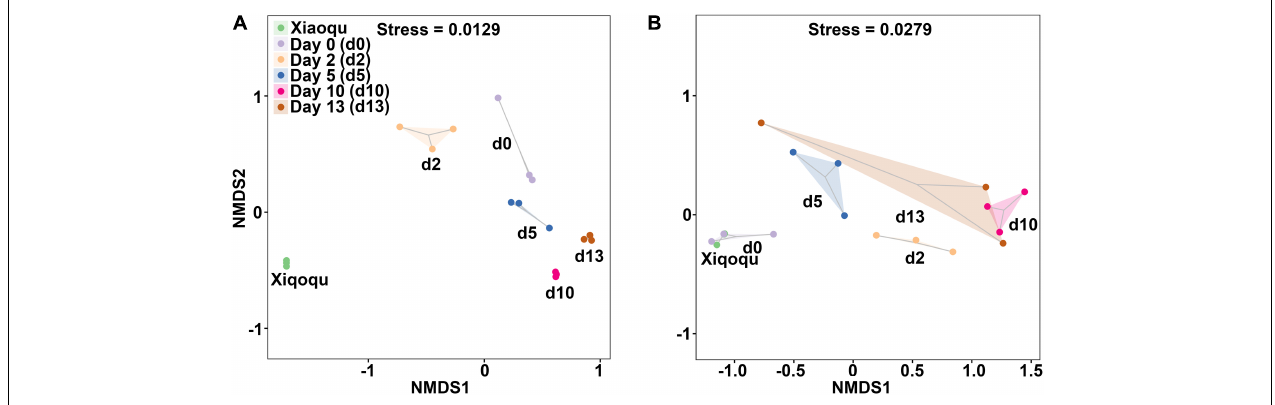
FIGURE 4 | Non-metric multidimensional scaling (NMDS) ranking of microbial community in the production of rice-flavor baijiu. Bacteria (A) , and fungi (B) . A closer distance between points indicates higher similarity; n = 3.